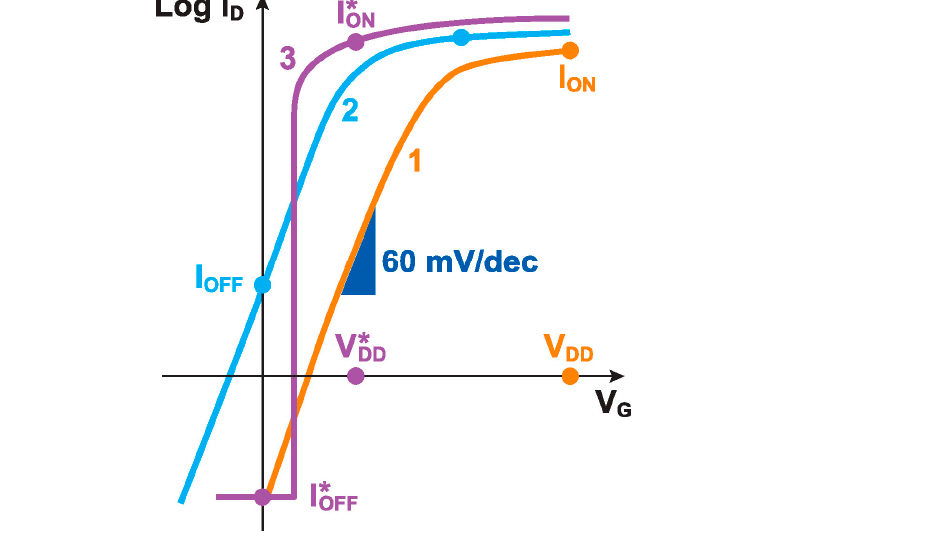
Figure 1. A schematic diagram of the tradeoff between power supply voltage V DD and power con- sumption. Curve 1 represents an ideal transistor with SS ≈ 60 mV/decade of I D at room temperature. Downscaling the threshold voltage is unavoidable for device miniaturization and power reduction, but this produces curve 2, with an unacceptable I OFF . An ideal sharp-switching device (curve 3) would provide the same or higher I* ON /I* OFF ratio when operated at a lower V * DD .